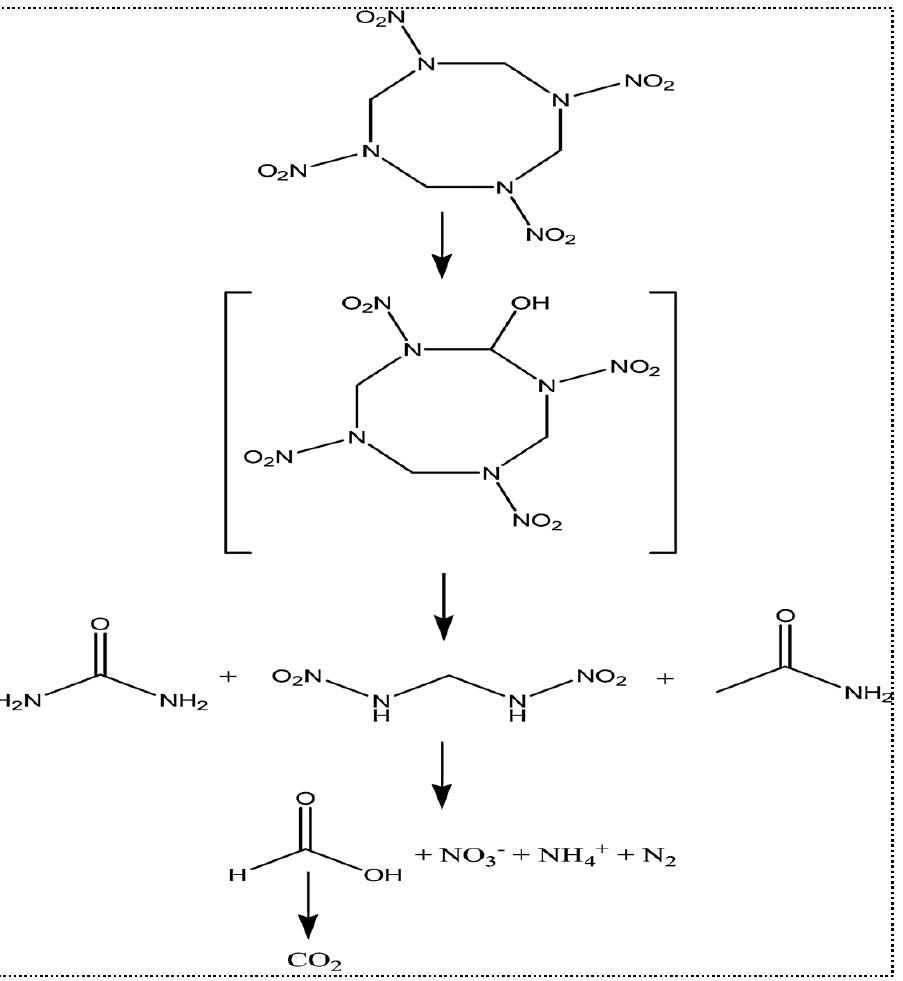
Figure 4. The HMX degradation mechanism in electro-assisted Fenton treatment. Adapted from Ref. [25] with permission from Elsevier.